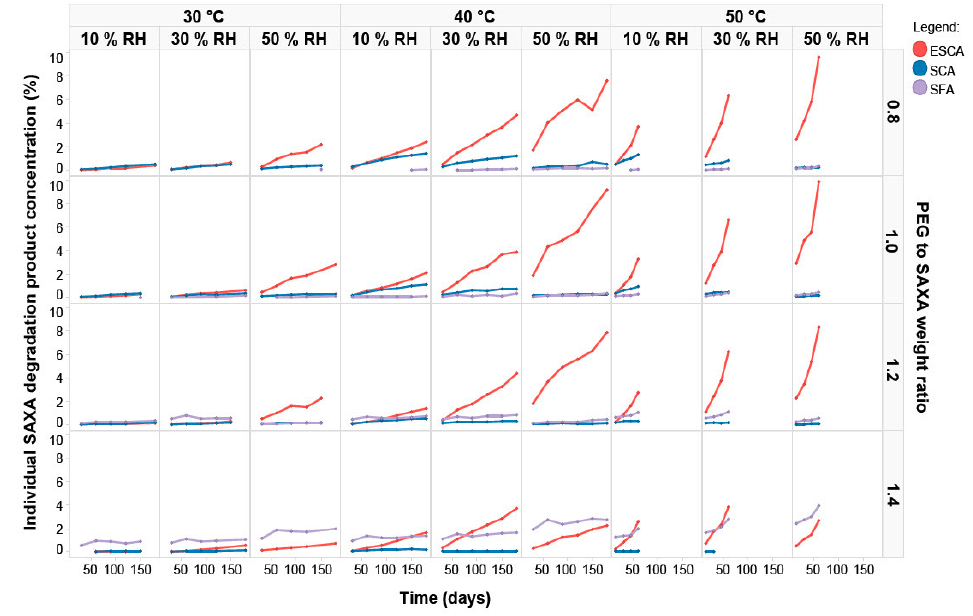
Figure 2. Saxagliptin (SAXA) degradation profile. Concentration of three main SAXA degradation products: cyclic amidine (SCA), epimer (ESCA) and formyl amide (SFA) are graphed on the y-axis (% against SAXA, w/w ), and time is graphed on the x-axis (days).